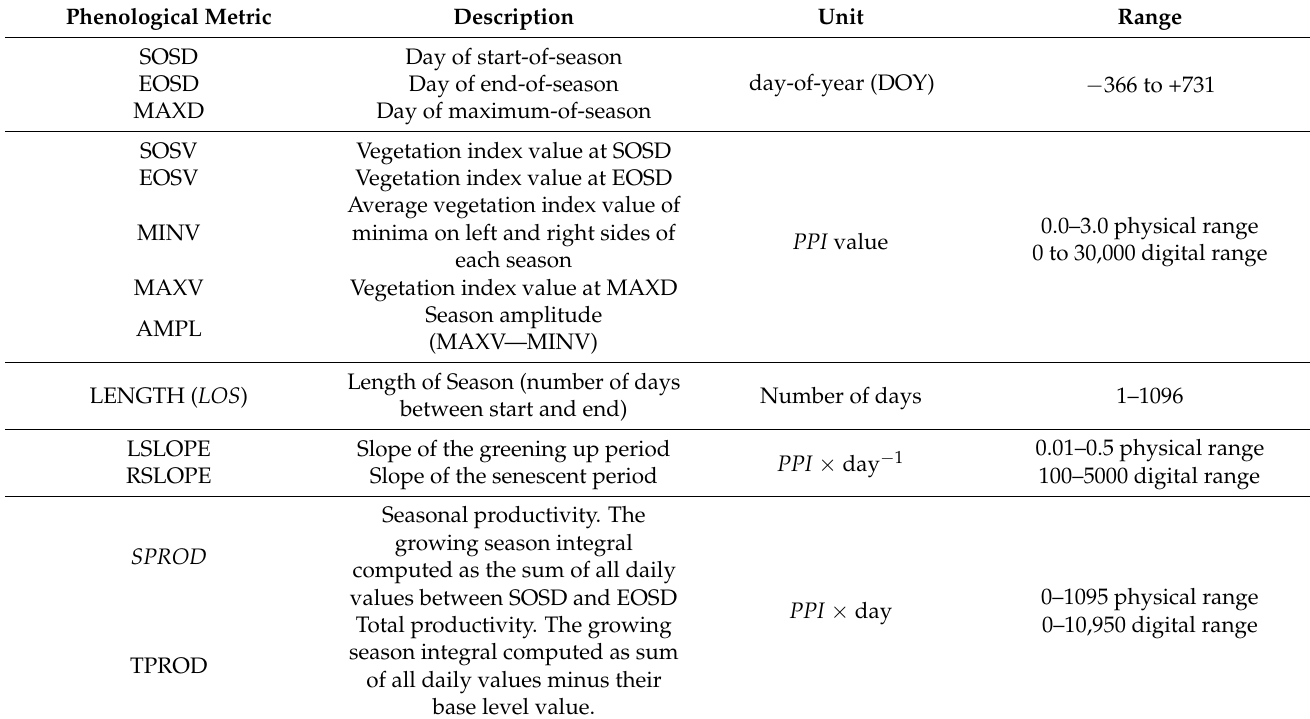
Table 2. List of metrics as mapped in the Copernicus HR-VPP dataset